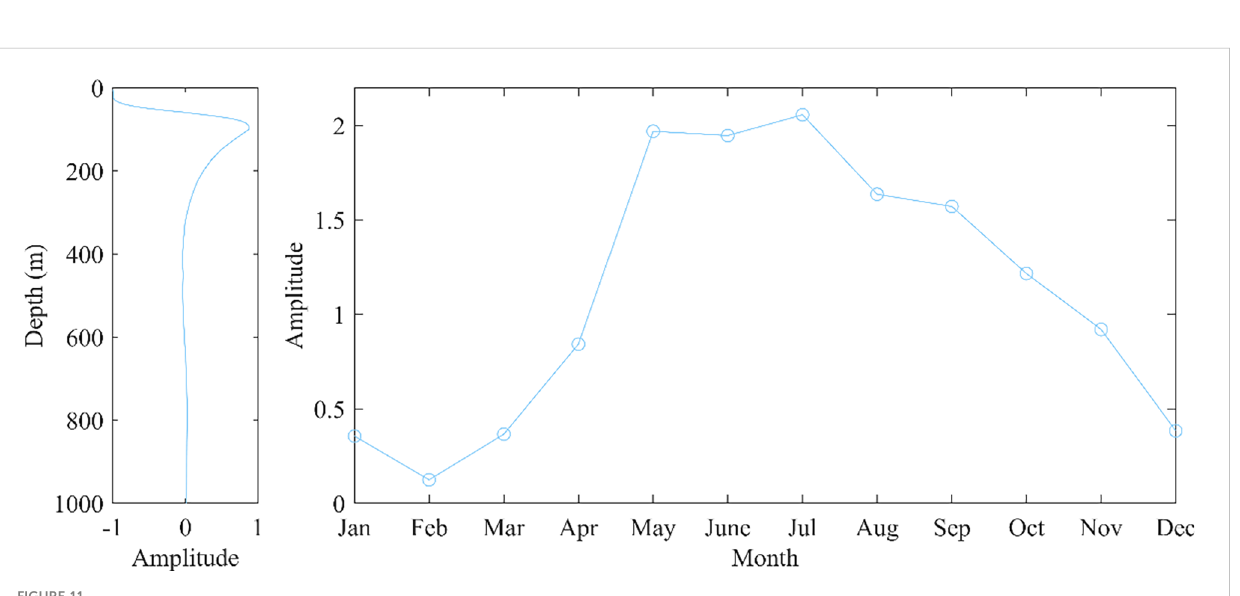
FIGURE 11 Time and space functions of Type 3.